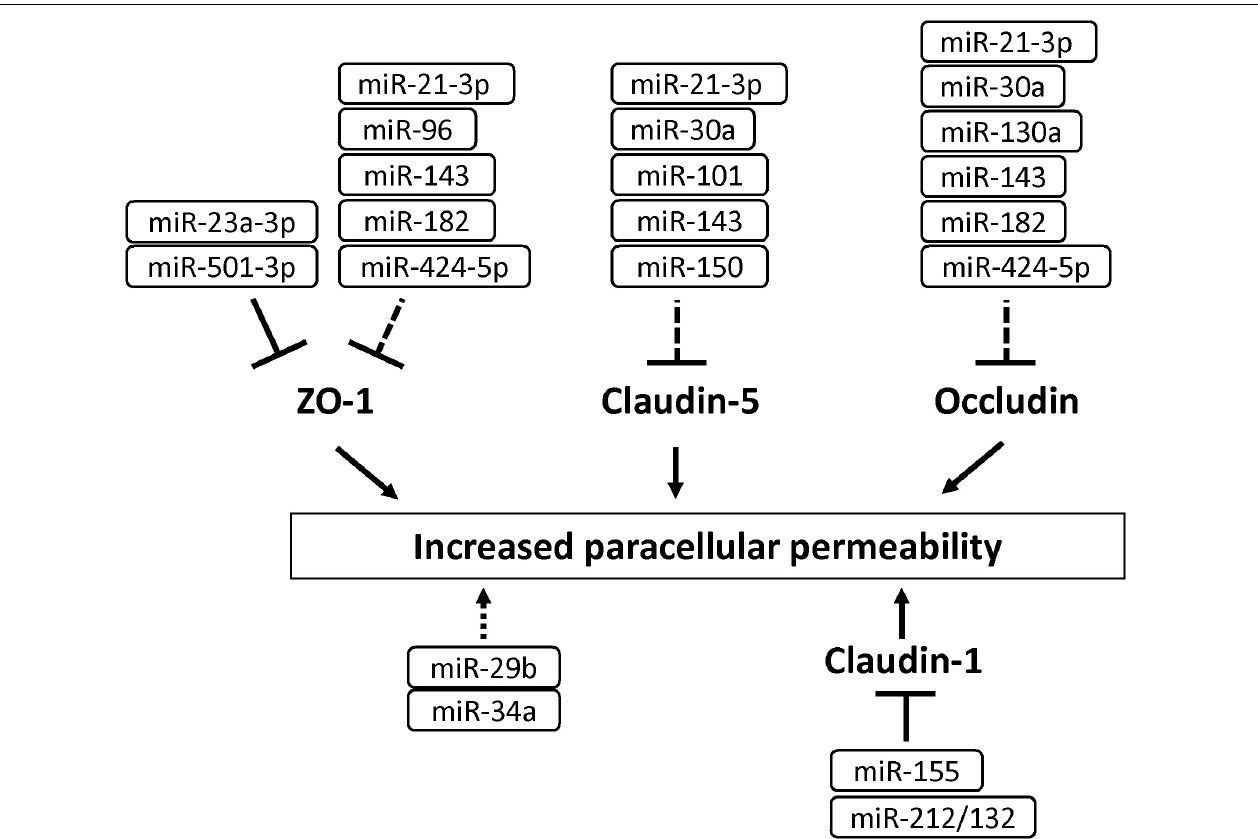
FIGURE 7 | MicroRNAs involved in the down-regulation of tight junction protein levels and BBB function in BMECs. Solid and dashed lines indicate that miRNAs directly and indirectly down-regulate tight junction-associated proteins, respectively.